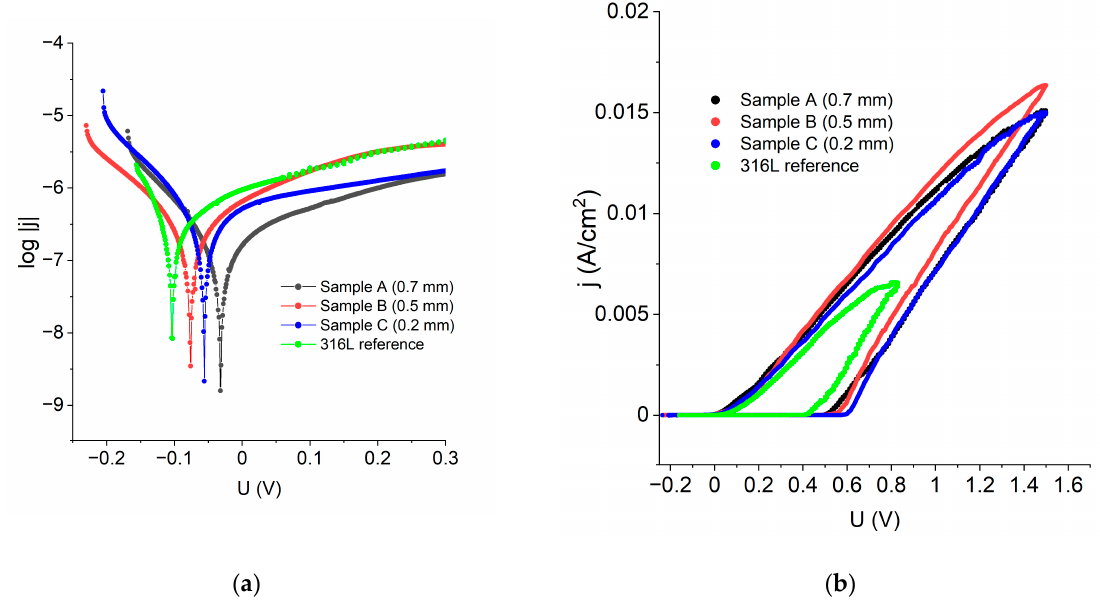
Figure 9. ( a ) polarization curves, in log|j|vs. E coordinates of the samples obtained via additive manufacturing and a reference 316L sample; ( b ) polarisation curves of the samples obtained via additive manufacturing and a reference 316L sample. Table 4. List of parameters of electrochemical corrosion (pitting and general) for all analysed samples.